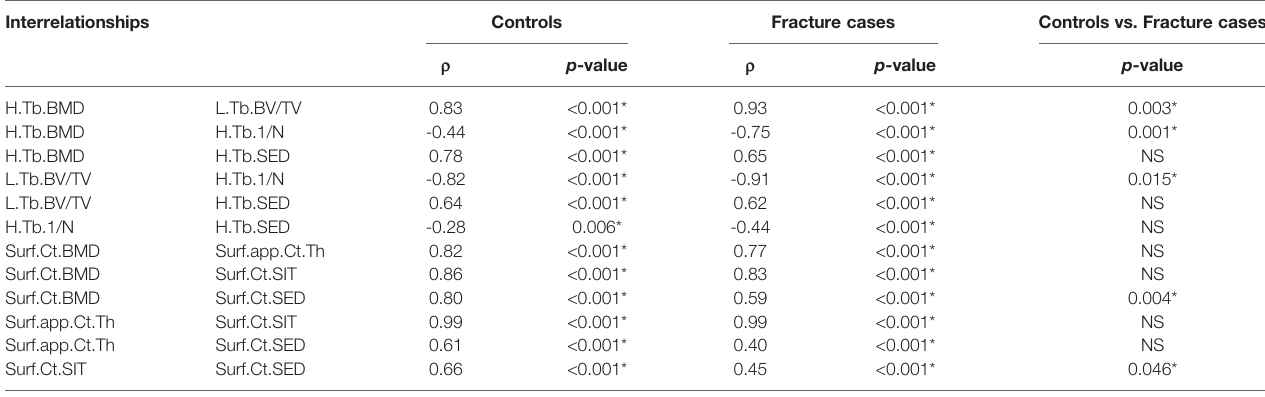
TABLE 5 | Global compartmental Spearman ’ s rank partial correlations for homogenized and local trabecular voxel-based parameters, and for cortical surface-based parameters with no spatial normalization. Interrelationships